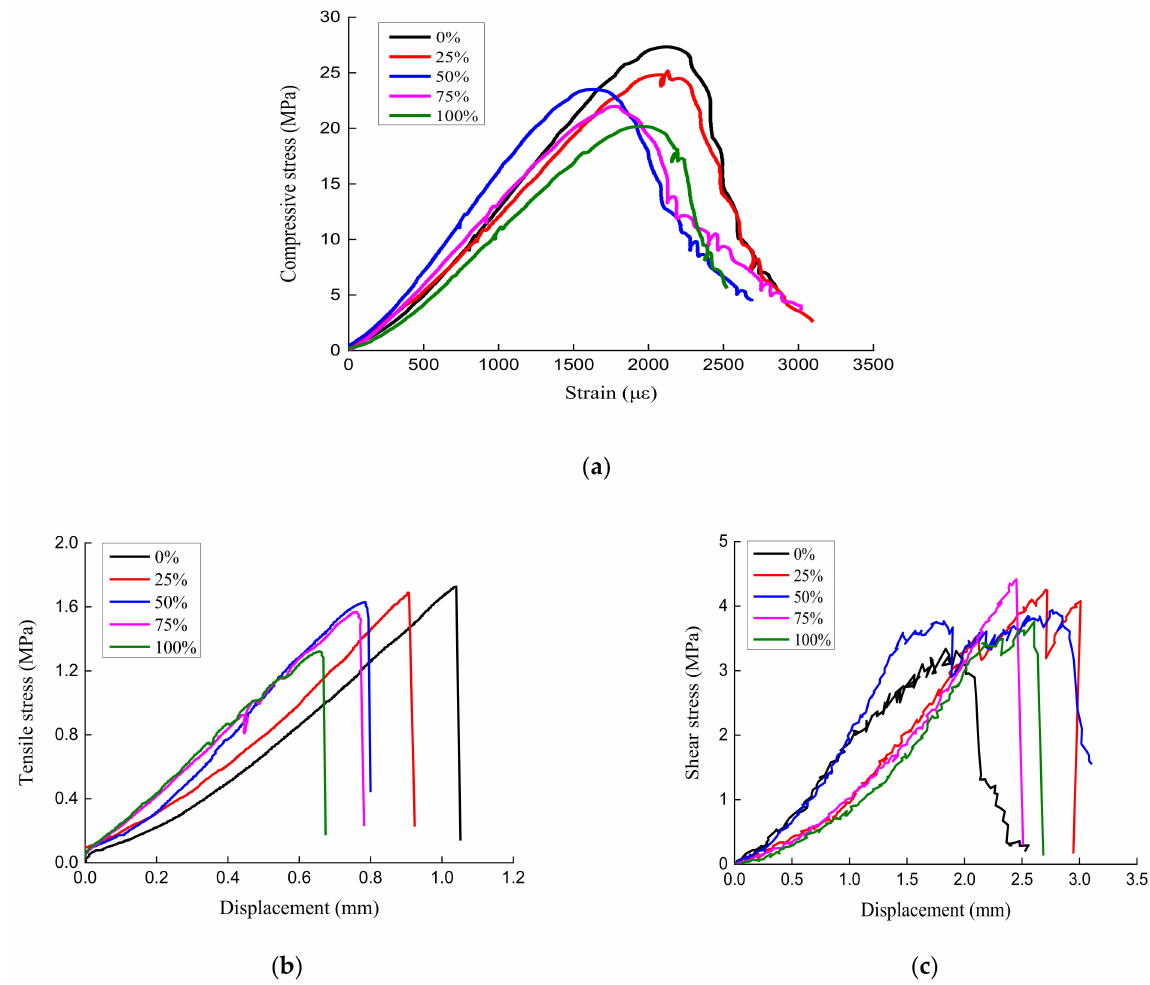
Figure 5. Stress–strain curves of recycled aggregate concrete for: ( a ) compression loading; ( b ) tension loading; and ( c ) shear